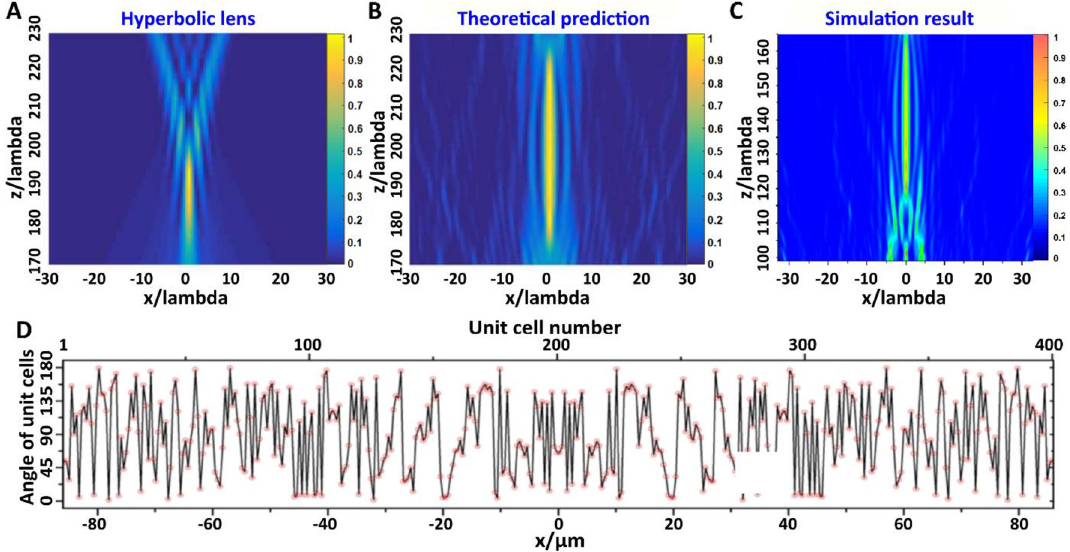
Figure 2: A light pattern generated by using the hyperbolic lens phase profile as initial condition (A); MATLAB-calculated light pat-tern using Green function in a typical case without imposing mutation boundary (B); and orientation angles of 400 unit cells for FDTD simulation (D); Lumerical FDTD simulation result with the phase profile obtained by the phase-change boundary